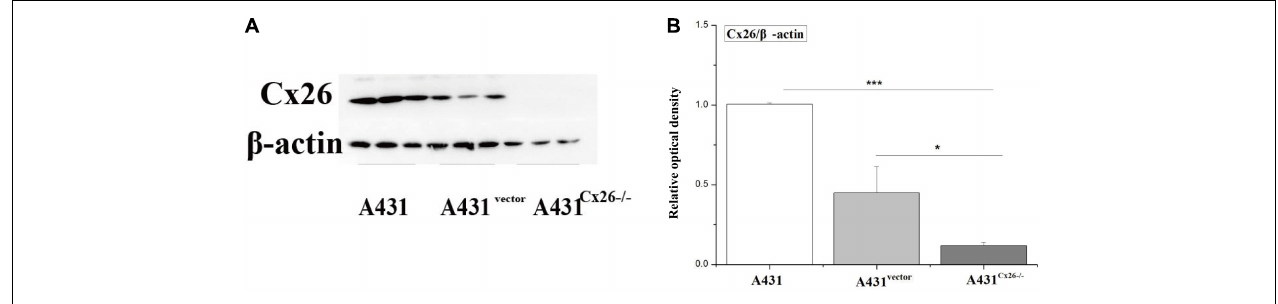
FIGURE 3 | Expression of Cx26 in A431, A431 vector , and A431 Cx26 − / − cells. (A) Cx26 expression levels in A431, A431 vector , and A431 Cx26 − / − cells. (B) Quantification of Cx26 expression in A431, A431 vector , and A431 Cx26 − / − cells. *** p < 0.001, * p < 0.05 between each cell